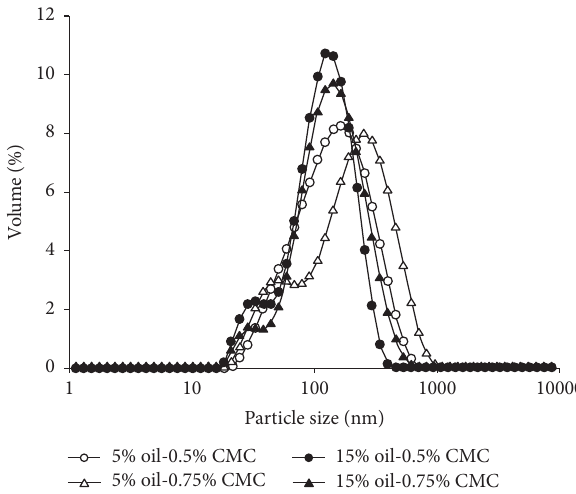
Figure 1: Particle size distribution of O/W nanoemulsions with different oil (5%: empty symbols and 15%: filled symbols) and CMC concentration (0.5%: circle and 0.75%: